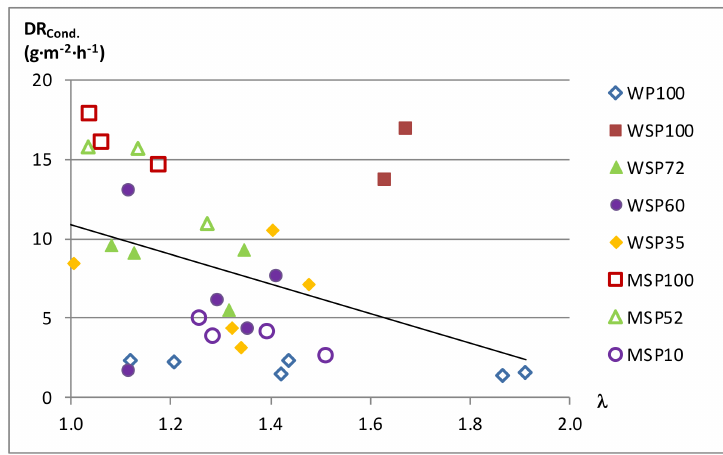
Figure 5. Deposition rates by condensation versus λ